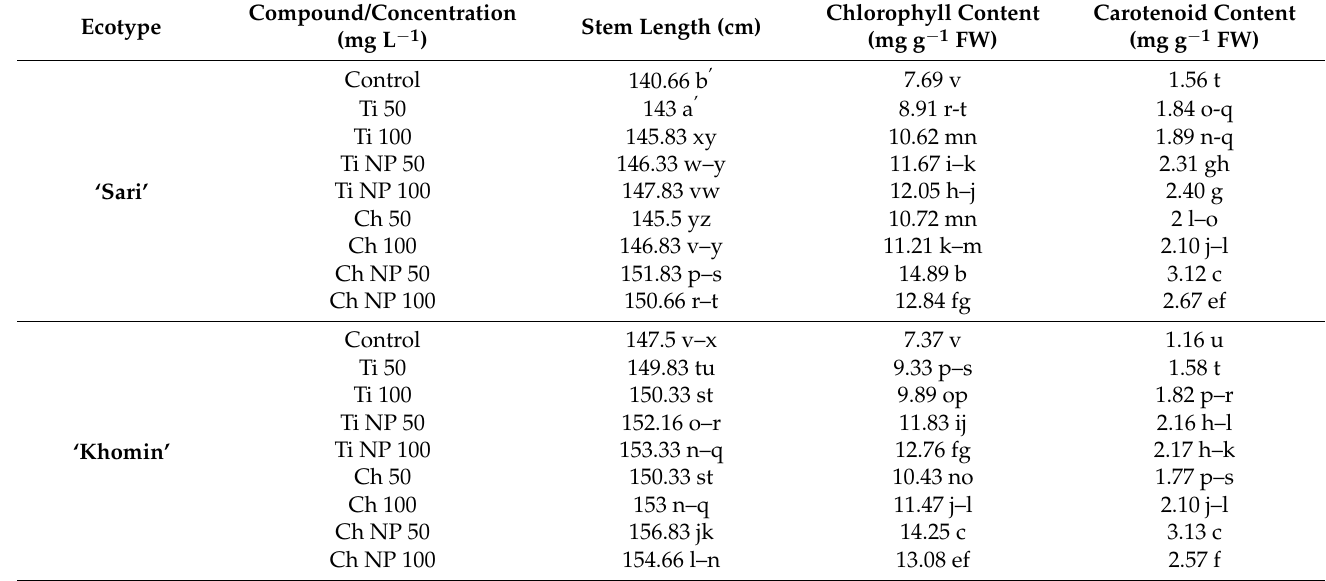
Table 3. Effects of chitosan and titanium dioxide (denoted as Ch and Ti, respectively) treatments [bulk, nanoparticle (NP)] applied at three concentrations (0, 50, and 100 mg L − 1 ) on stem length and leaf photosynthetic pigment content of five milk thistle ecotypes. Three plants per treatment were assessed. Different letters within a column indicate statistically significant differences ( p < 0.05). FW, fresh